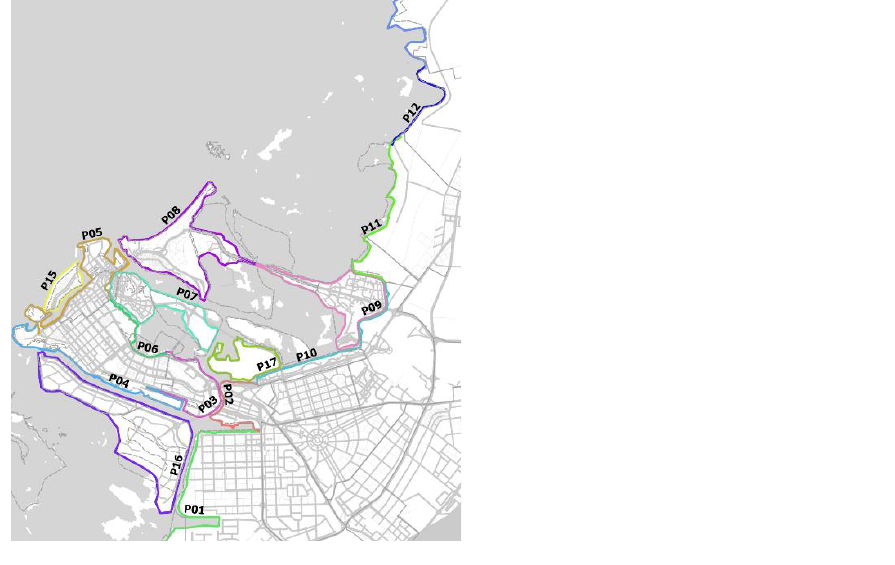
Figure 7. Theoretical protection levees for 17 different precincts based on precinct boundaries defined in [44]. Table 1. Matrix of the changes in inundated areas in different precincts by protecting individual precinct. The columns represent each protection case. For example, the first column represents changes in inundated areas (expressed as a percentage of the total precinct area) of different precincts by protecting P01—Mussafah. Pink/red shades denote an increase in inundated area for the individ- ual precinct; green shades indicate a